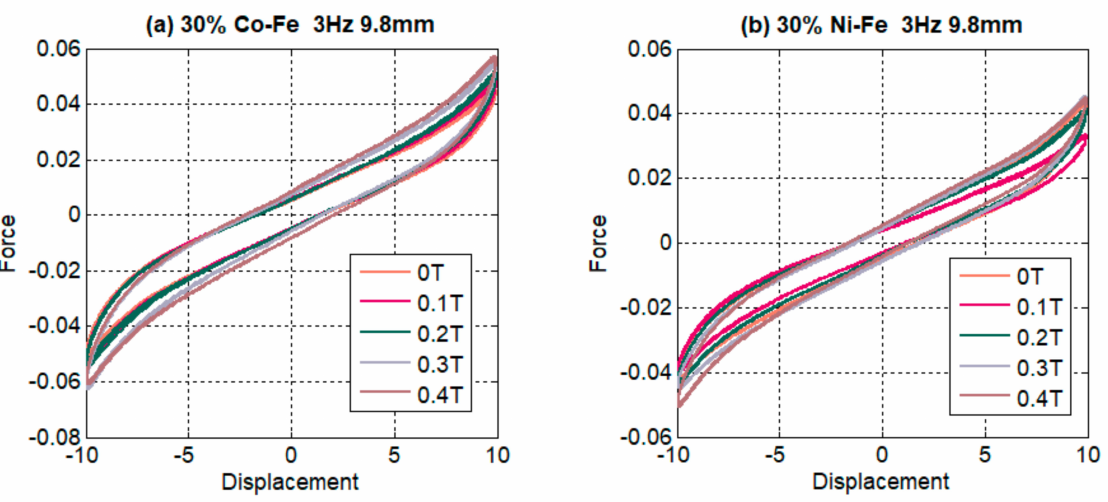
Figure 12. Comparison of ( a ) 30% Co-Fe MRE and ( b ) 30% Ni-Fe MRE force-displacement graphs with respect to changing flux.